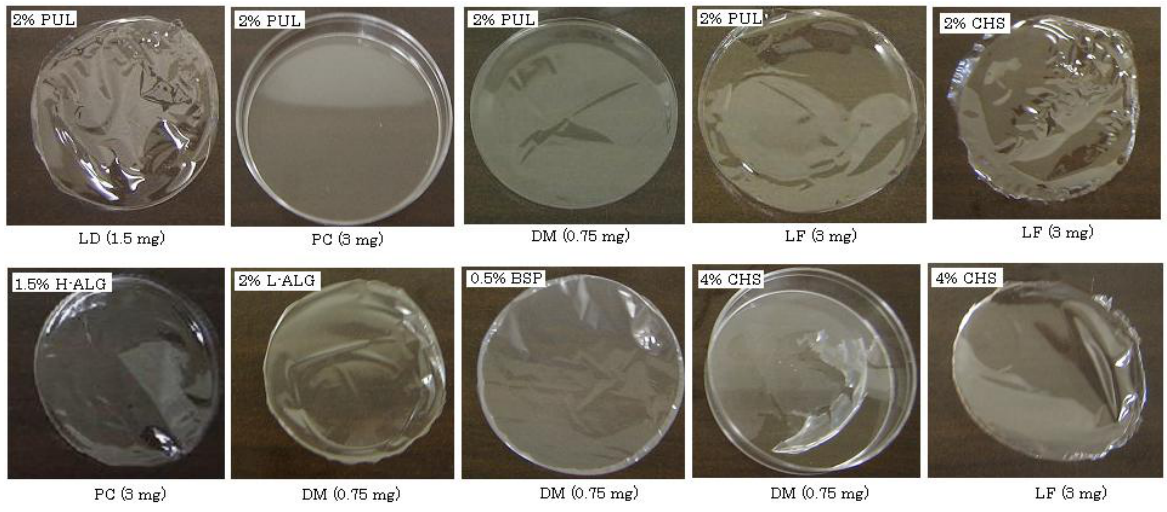
Figure 1. Pictures of FDFs prepared with polysaccharides containing various model compounds.